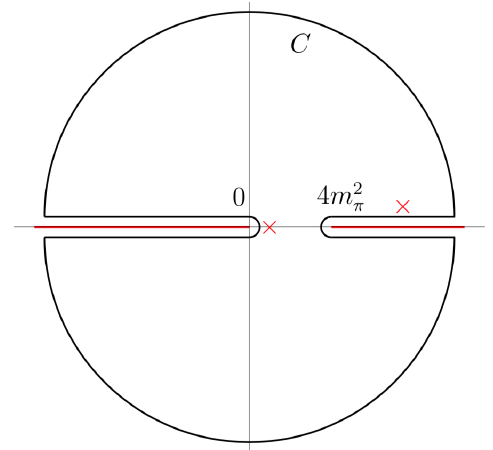
Figure 1: Analytic structure of elastic scattering partial waves for pions and the con- tour C in the complex- s plane that will be used to write a dispersion relation for the inverse amplitude. The red lines represent the discontinuity cuts in the partial wave amplitude. The red crosses additionally represent the n -th order pole at z = ε and the simple pole at z = s + i ε (with s > 4 m 2 ) coming from the denominators in Eq.